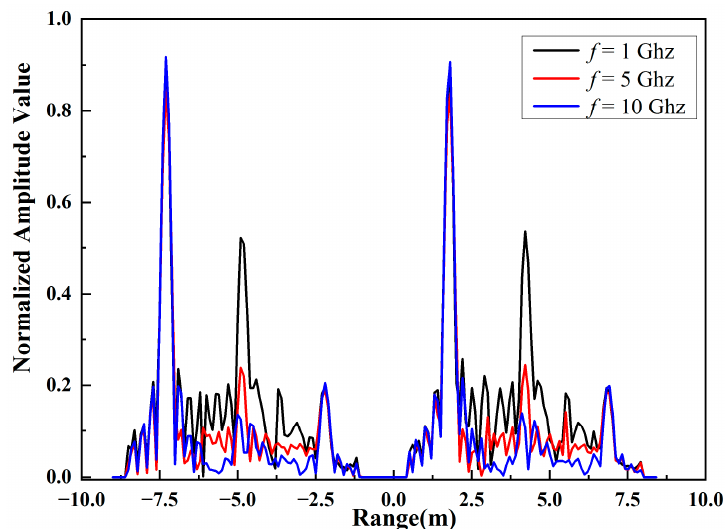
Figure 14. The HRRP of hybrid dielectric and conductor missile-like targets with different incident frequency in the free space.